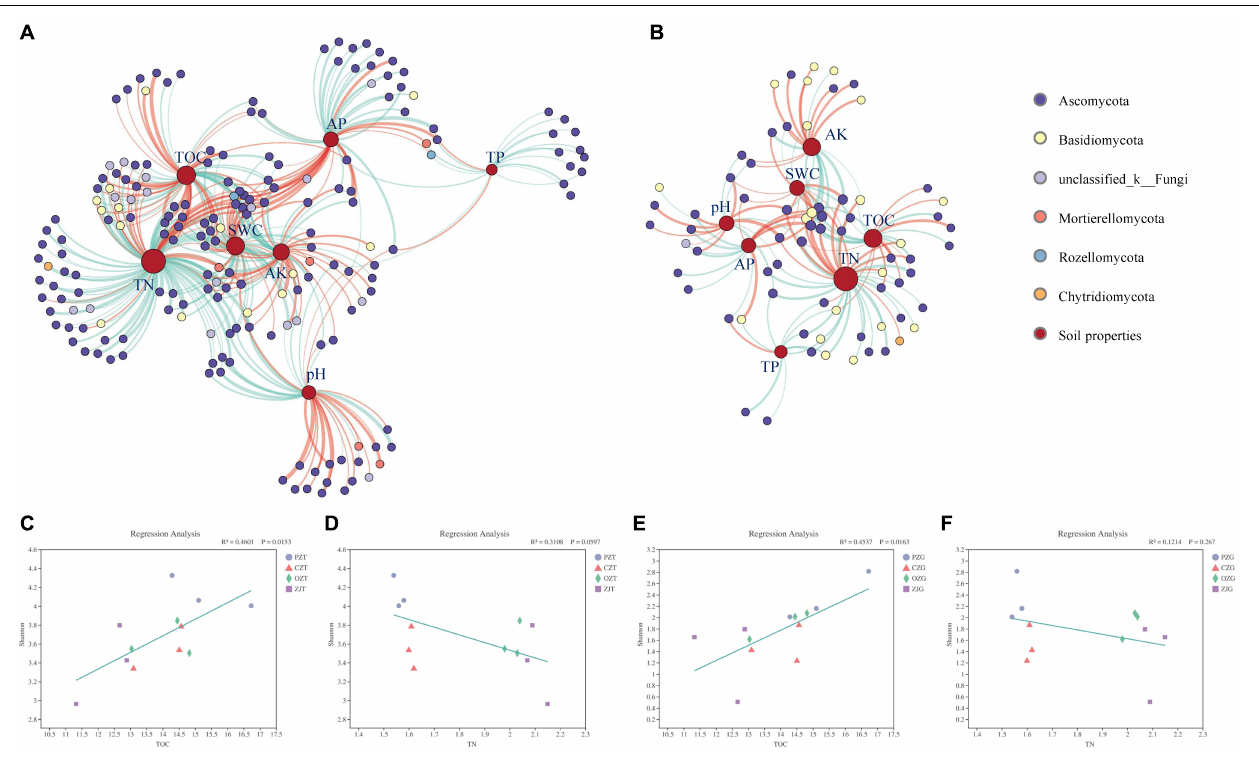
FIGURE 5 | Two-factor correlation network between soil properties and fungi OTUs ( A : the rhizosphere soil, B : the root endospheres). Node color represents fungal phylum of the OTU. Node size is proportional to degree connections of the OTU. Red edges indicate positive relationships, and green edges indicate negative relationships. The linear regression analysis of environmental factors was based on the results of principal coordinates analysis (C–F) . X and Y axes are the Shannon diversity of fungi and the environmental factor, and R2 is the determination coefficient, representing the proportion of variation explained by regression